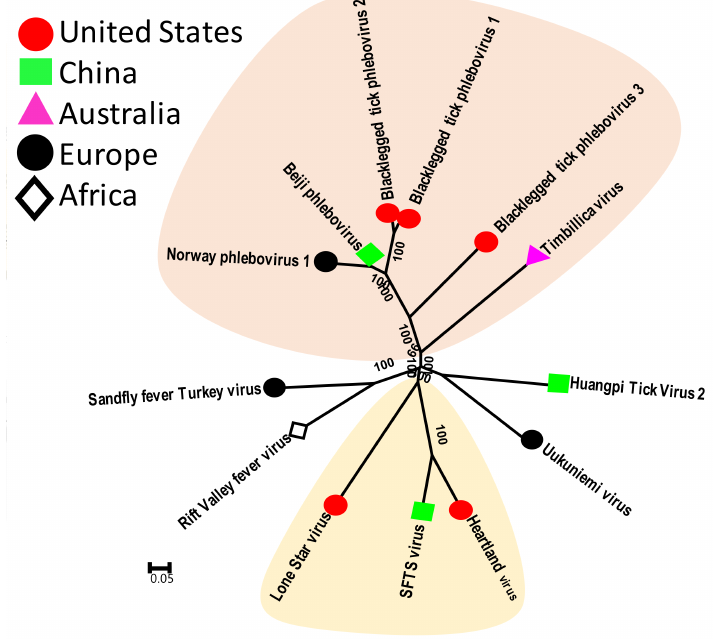
Figure 2. Phylogenetic relatedness among tick phleboviruses. This analysis involved 13 amino acid sequences of the viral polymerase gene. Genbank accession numbers of sequences used for phylogenetic analysis are: YP_009293590 Huangpi Tick Virus 2, NP_941973 Uukuniemi virus, YP_004382743